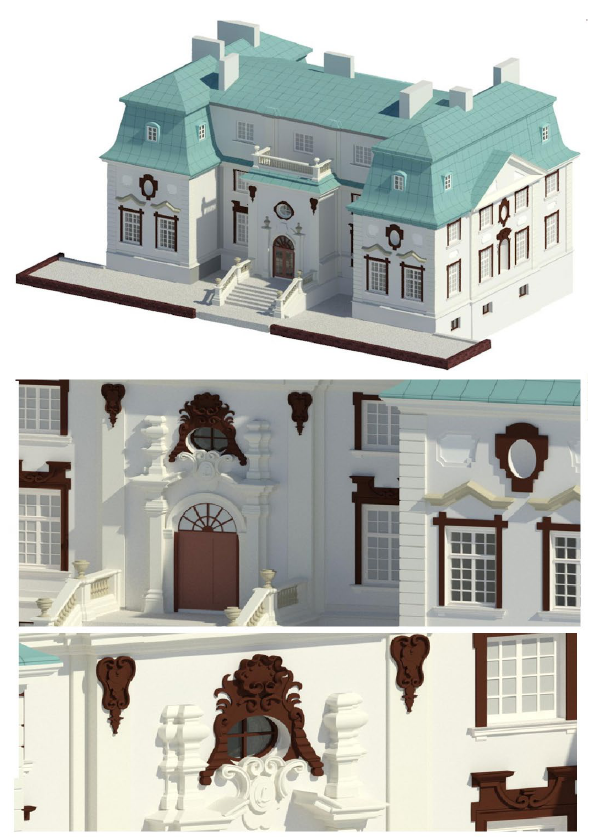
Fig ure 5. Example of a highly detailed BIM façade - historic building